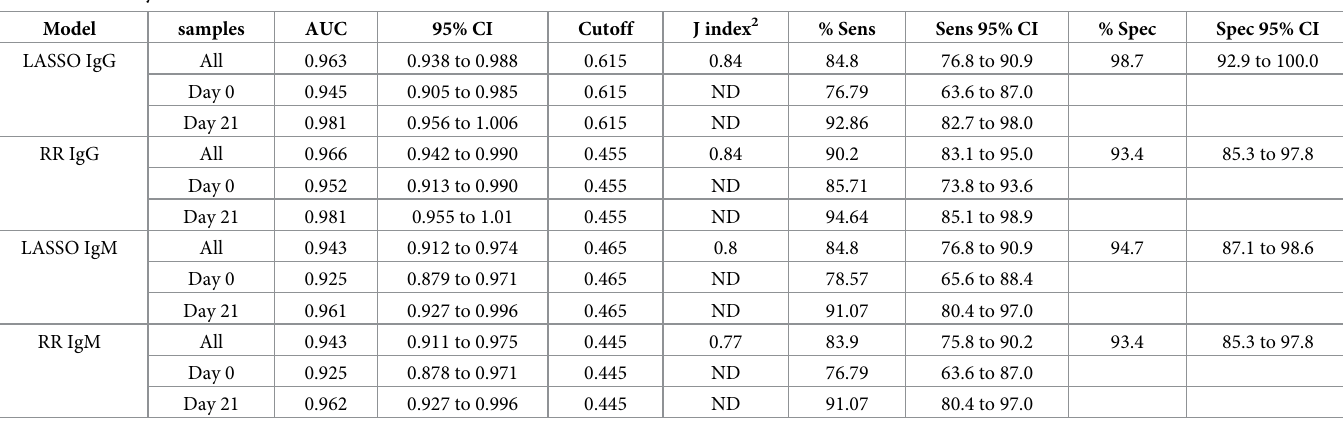
Table 4. Summary information for each multivariate